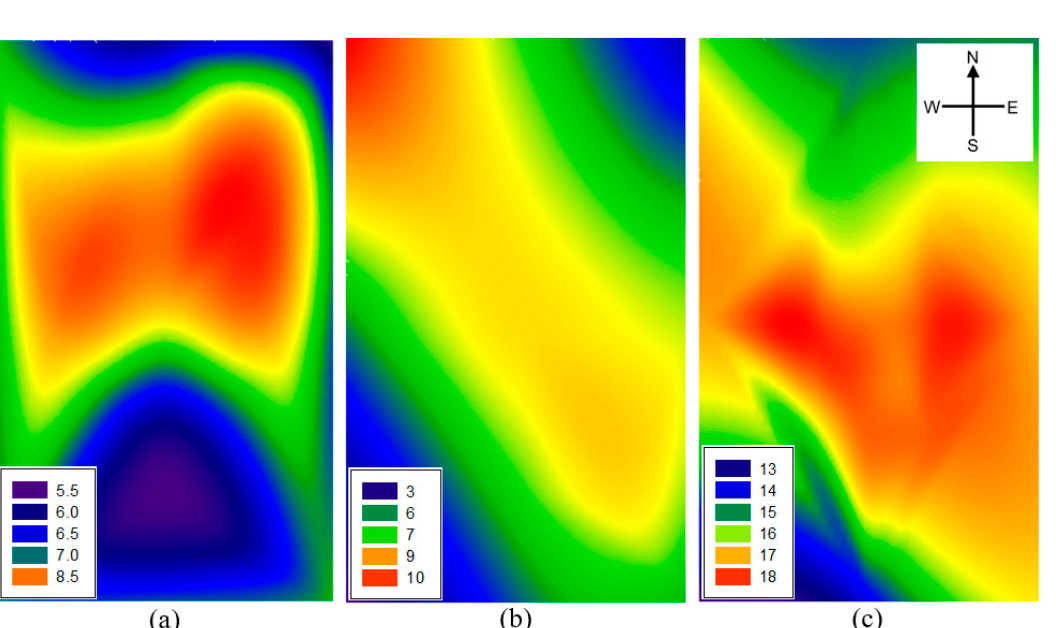
Figure 4. Changes in the spatial distribution of ammonia (NH 3 ) concentration ( μ g·m − 3 ) in the study